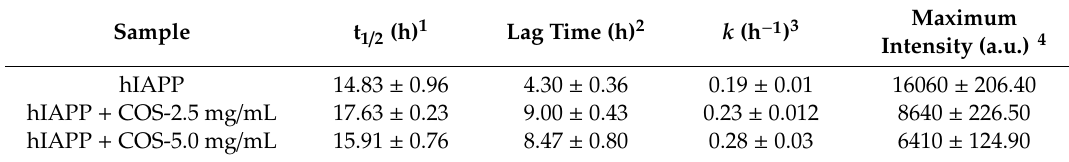
Table 1. Kinetics of hIAPP, incubated in the absence or presence of COS.